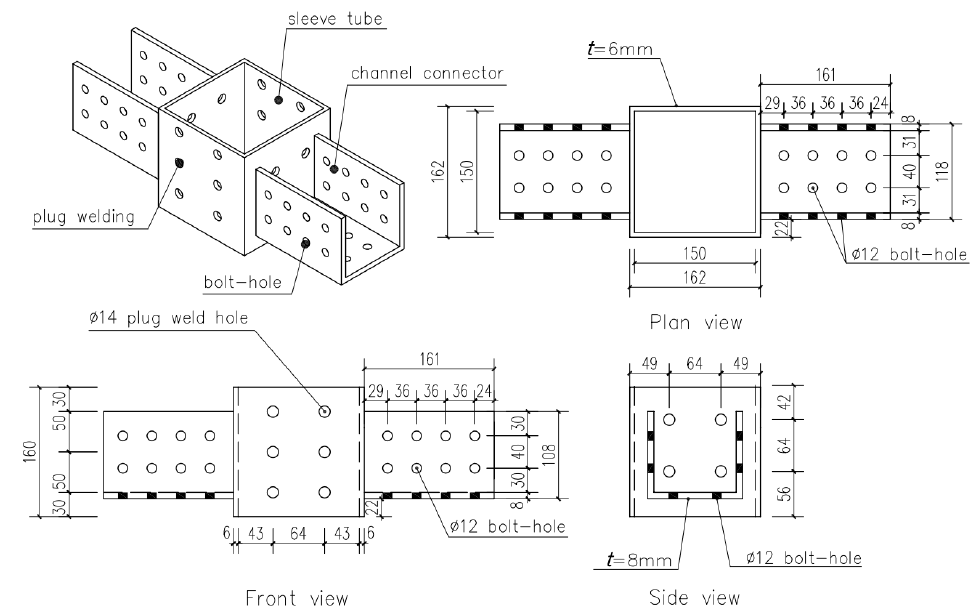
Figure 6. Double-channel connector welded with the SHS sleeve tube.